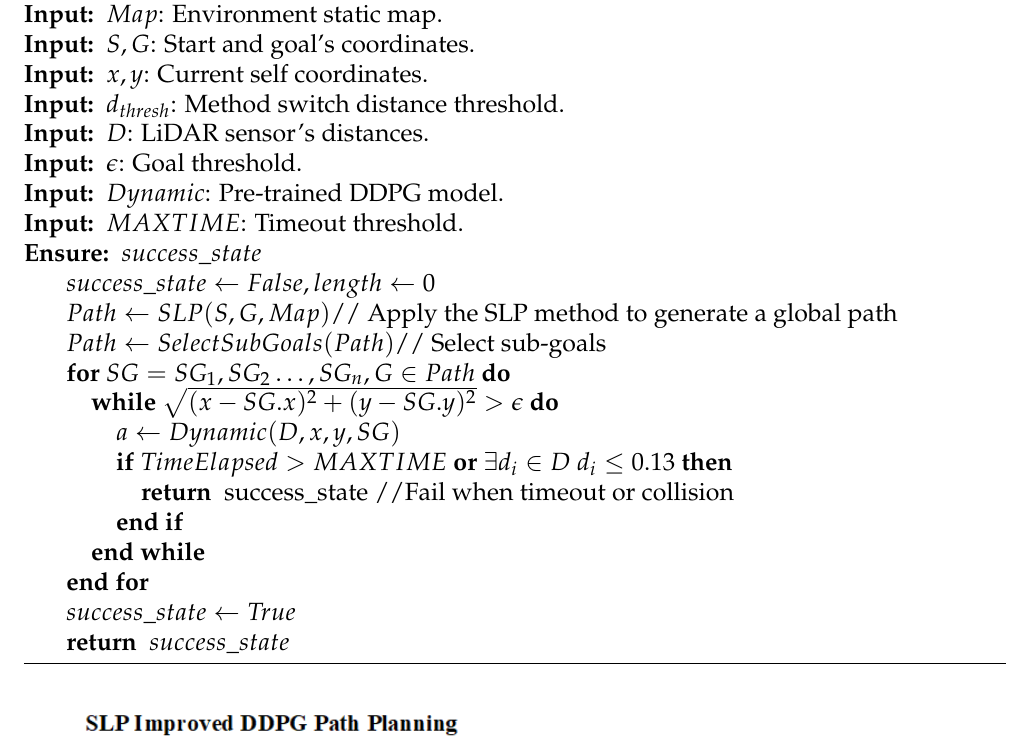
Algorithm 1 SLP-improved DDPG path planning algorithm